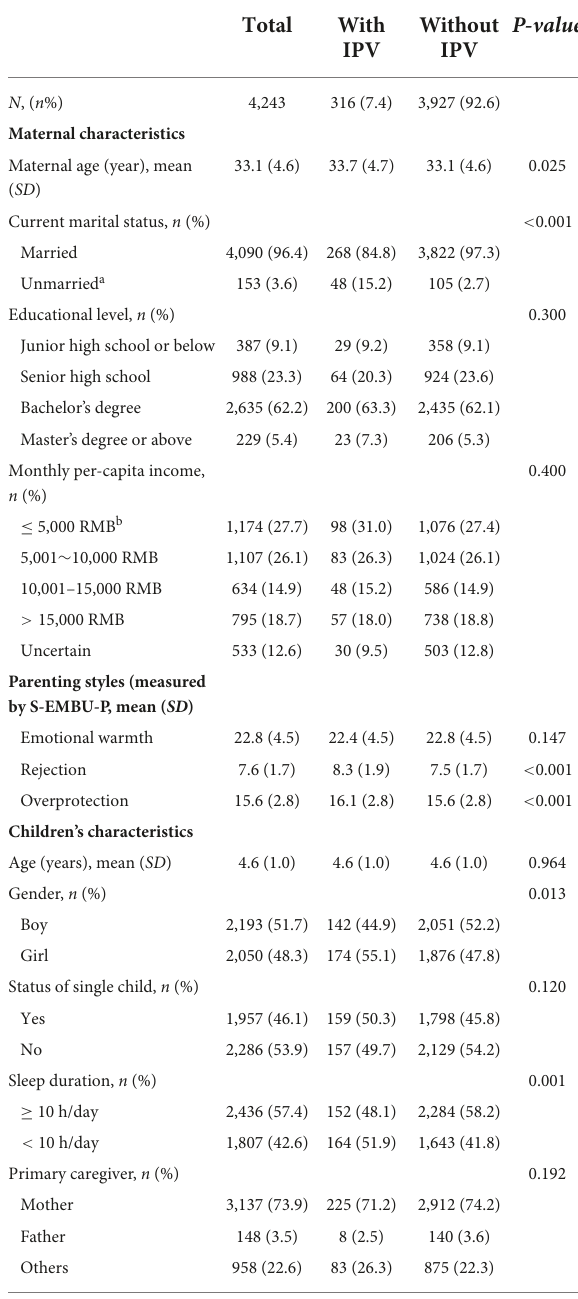
TABLE 1 Comparison of characteristics of children and mothers by maternal IPV